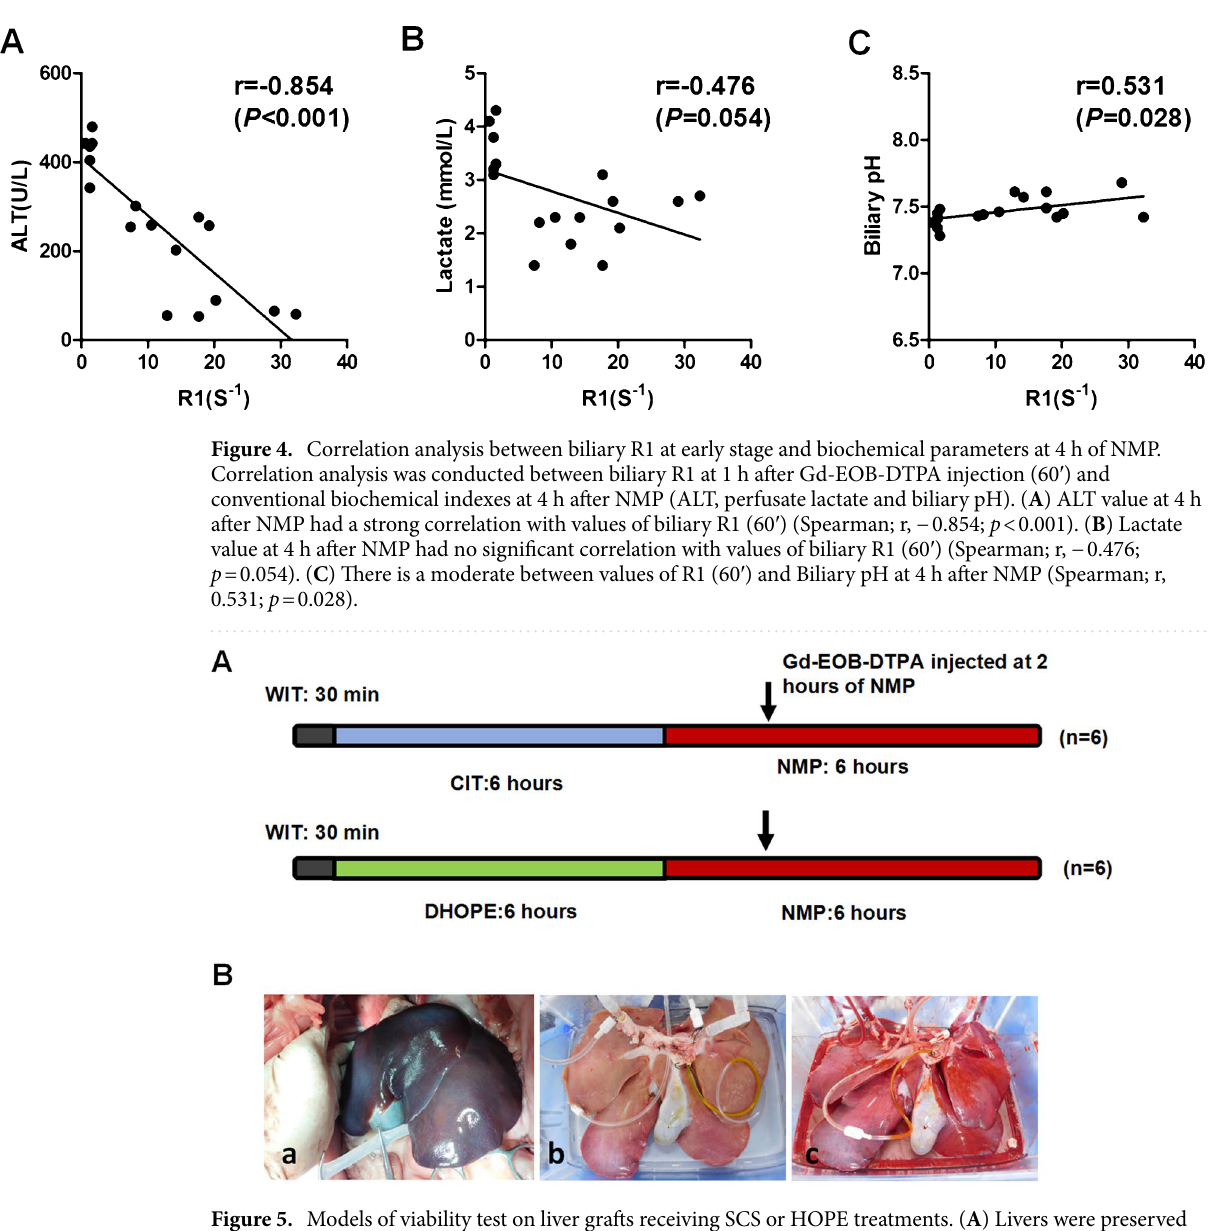
Figure 5. Models of viability test on liver grafts receiving SCS or HOPE treatments. ( A ) Livers were preserved in static cold storage (n = 6) or HOPE (n = 6) for 6 h after 30 min of warm ischemia. Then livers were allowed to cannulate to NMP. Gd-EOB-DTPA was injected 2 h after starting NMP, and bile or blood samples were collected at indicated time points. ( B ) Representative images of the liver treated with warm ischemia in situ (a), liver graft connected to the ex situ DHOPE in 4 °C (b), and liver graft connected to the ex situ NMP